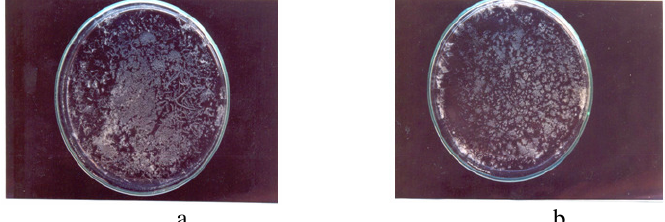
Figure 9 . Photographs of trees / bushes like pattern in absence of bromate and ferroin, (a) Succinic Acid, [0.128 M], Ce +4 , [0.022 M], Ethylacetoacetate, [0.120 M], H (b) Succinic Acid, [0.128 M], Ce +4 , [0.022 M], Ethylacetoacetate, [0.120 M], H id = 9.1 cm, thickenss of solution = 0.1 cm, Temperature = 30 ° C.